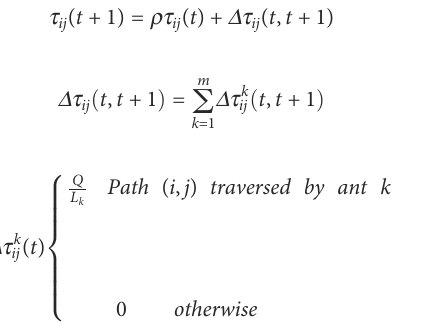
FIGURE 3 Diagram of the fl ight